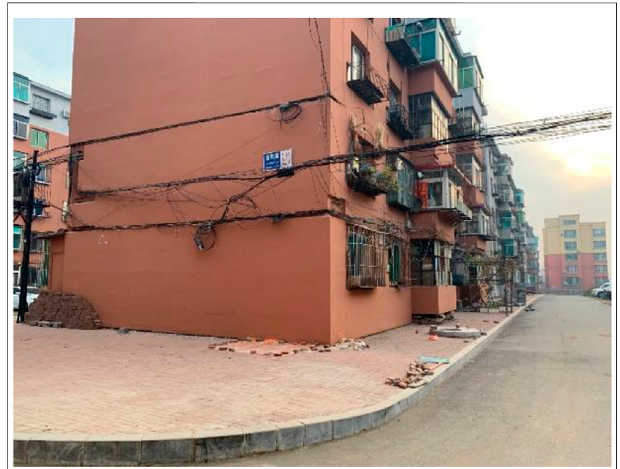
FIGURE 8 | Separation of building a wall from the foundation in feature- 3